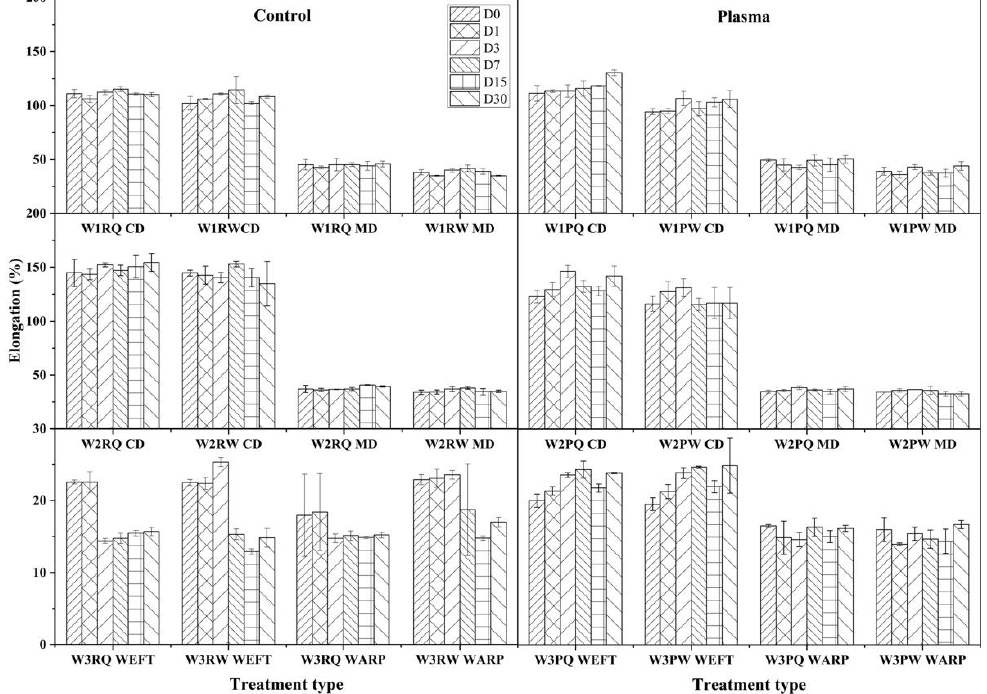
Figure 4. Elongation at break (%) change of control (R) and plasma-treated (P) wipe samples during 30 days of storage time. (D0 to 30 represented 30 min, 1, 3, 7, 15, and 30 days’ immersion time) .